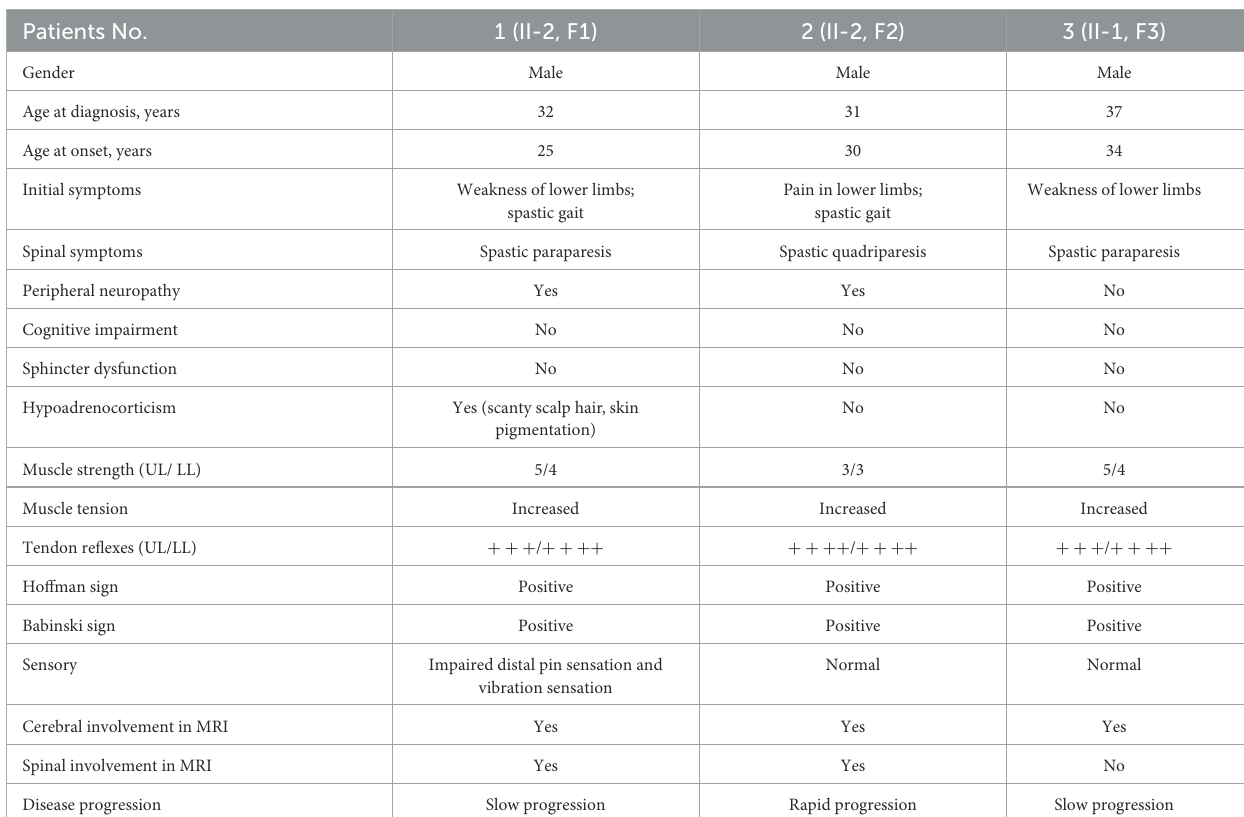
TABLE 1 Clinical characteristics of three patients with AMN. Patients